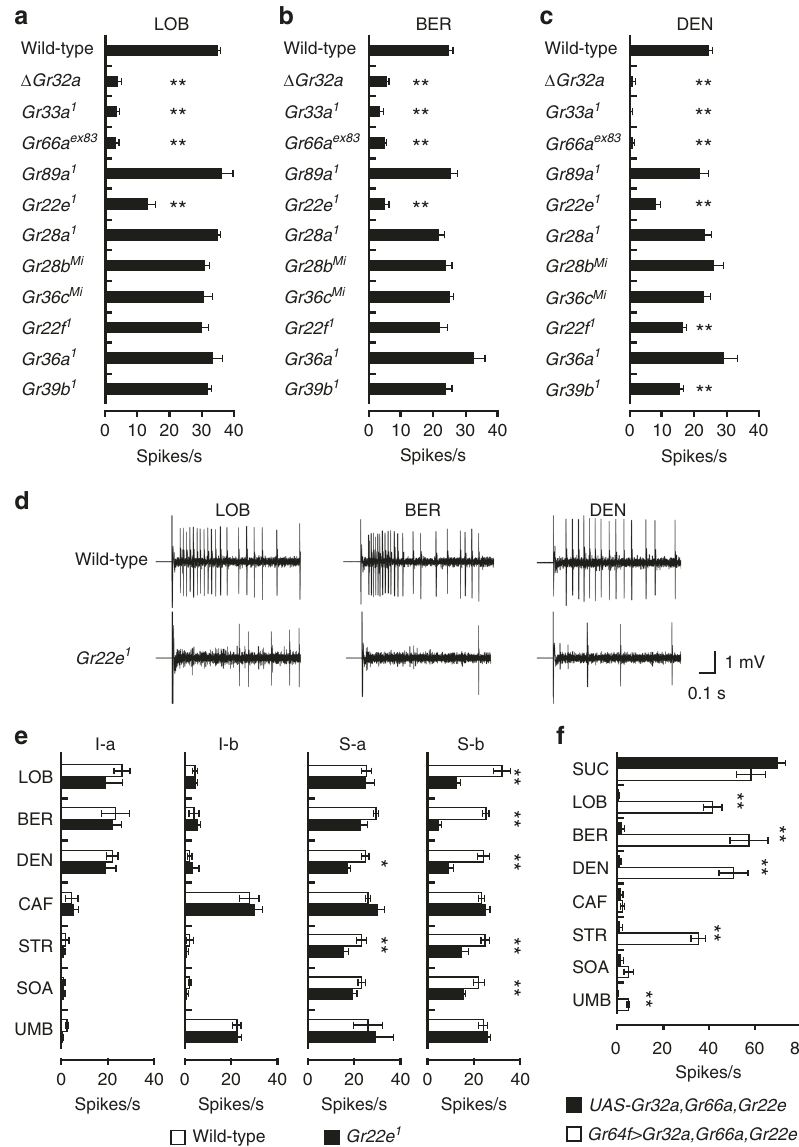
Fig. 3 Identi fi cation of Grs for LOB, BER, and DEN detection in S-b sensilla. a – c Screening to identify the Grs required for the responses in S-b sensilla to LOB a , BER b , and DEN c . 1 mM of each chemical was used. n = 8 – 31. ANOVAs with Tukey or Dunnett T3 post hoc tests or Kruskal − Wallis tests with Mann − Whitney U post hoc tests as appropriate. The asterisks indicate statistically signi fi cant differences from wild-type fl ies. d Representative traces from wild-type and Gr22e 1 S5 sensilla upon application of LOB, BER, and DEN. e Mean responses of the indicated sensilla from wild-type and Gr22e 1 fl ies to 1 mM stimulations with the indicated bitter substances except 5 mM CAF. n = 6 – 30. Unpaired Student ’ s t -tests or Mann − Whitney U -tests as appropriate. f Mean responses of Gr32a , Gr66a , and Gr22e -expressing L-type sensilla induced by 1 mM stimulations with the indicated chemicals except 100 mM SUC and